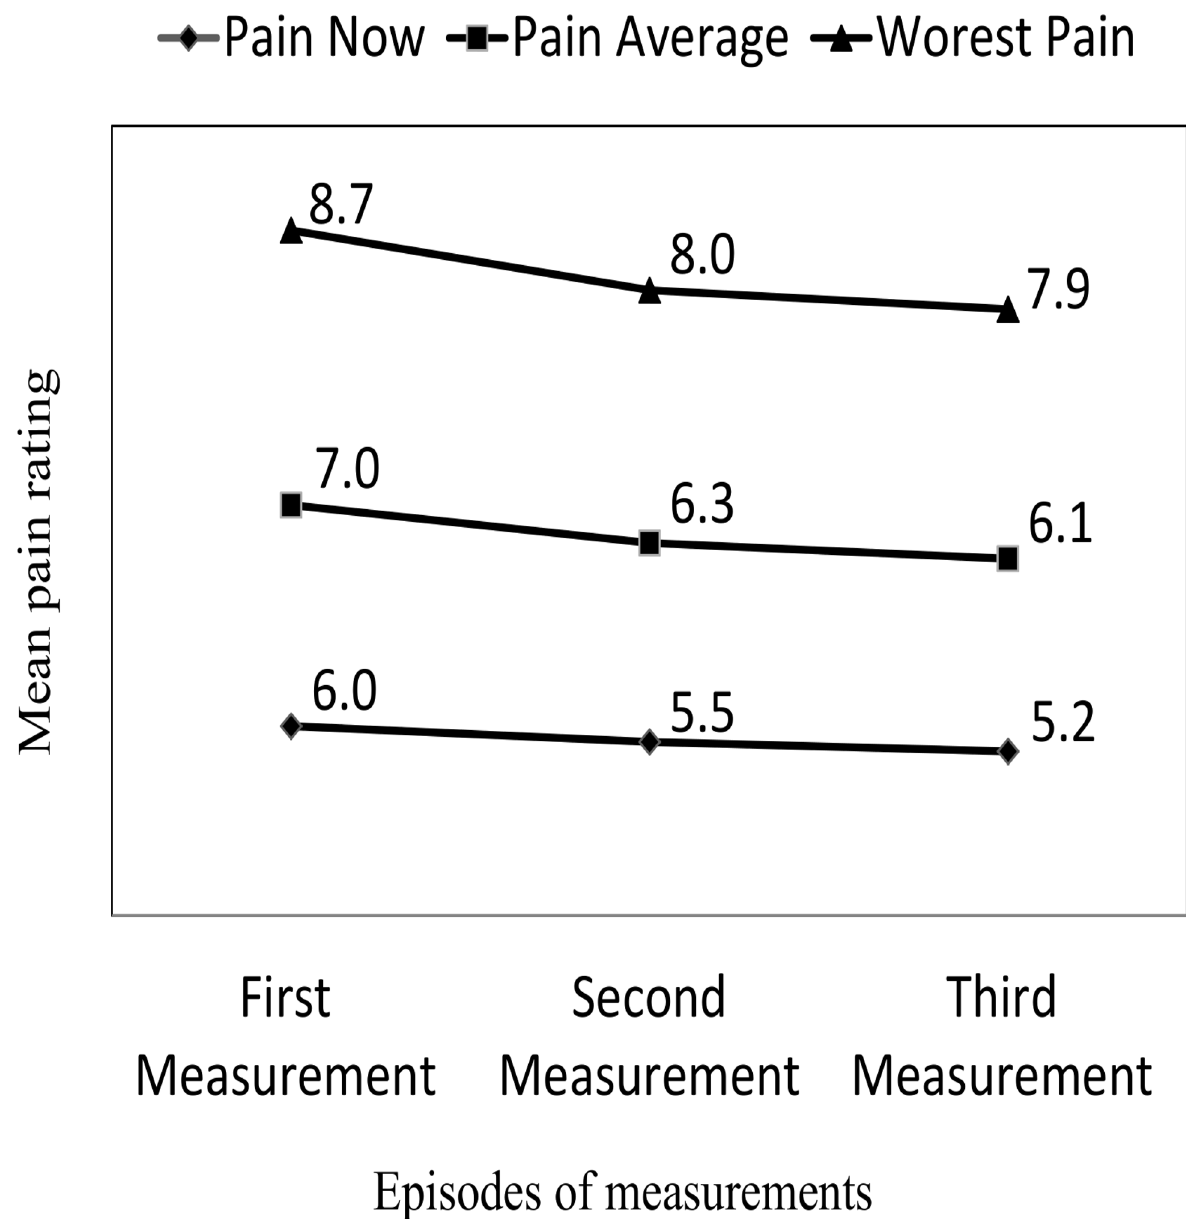
Figure 2. Mean pain intensity rating over the three measurements.